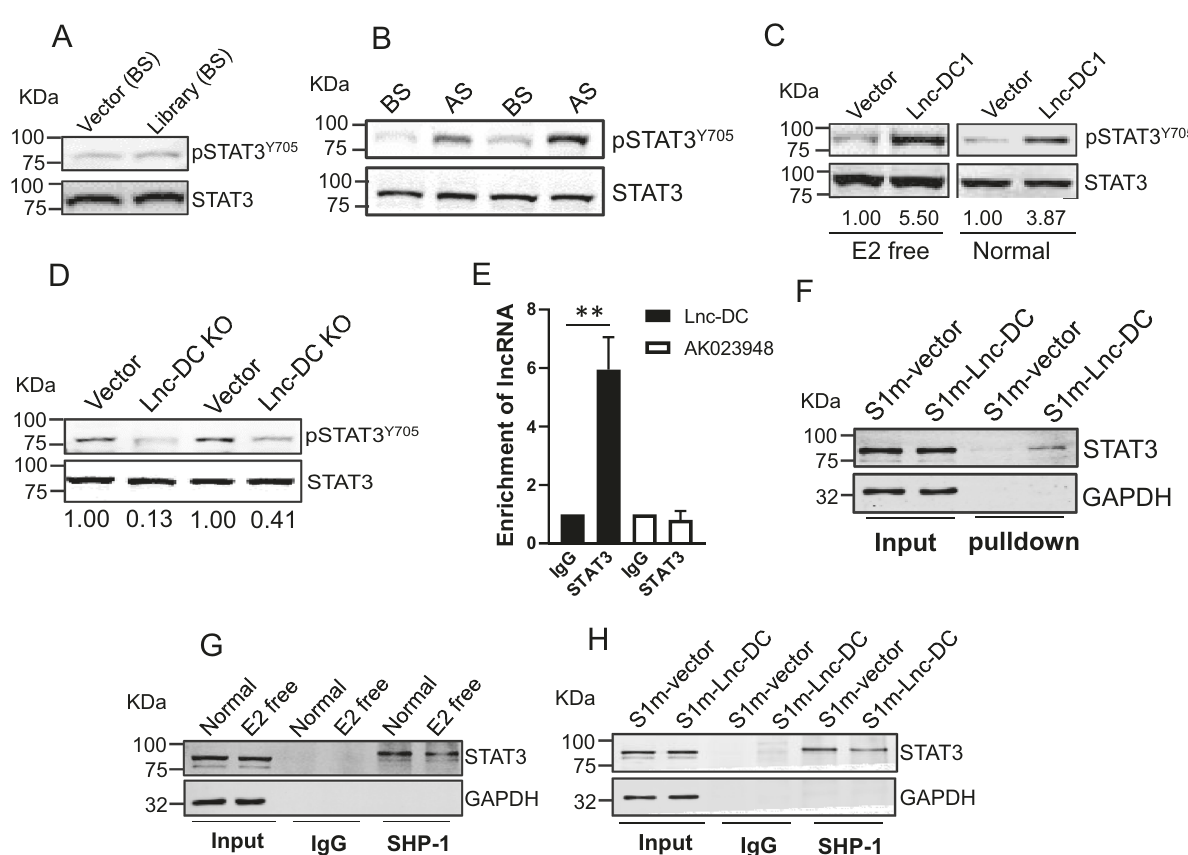
Fig. 4 Lnc-DC promotes STAT3 activity by its interaction with STAT3. A There is no difference between vector control and library cells in the level of pSTAT3 Y705 before selection. B AS cells express a higher level of pSTAT3 Y705 than BS cells. C Lnc-DC1 upregulates the level of pSTAT3 Y705 as compared to vector control in either E2 free or normal medium. D Lnc-DC KO decreases the pSTAT3 Y705 level. E Lnc-DC interacts with STAT3, as determined by RNA immunoprecipitation using STAT3 antibody. AK023948 serves as a negative control. Values are mean ± SD ( n = 3). ** p < 0.02. F Interaction of Lnc-DC with STAT3 as determined by in vivo precipitation assay. MCF-7 cells were infected with S1m- Lnc- DC or S1m vector control. Two days later, cellular extracts were prepared for streptavidin precipitation, followed by western blot. G Estrogen deprivation reduces the interaction between STAT3 and SHP-1, as determined by co-immunoprecipitation with SHP-1 antibody. MCF-7 cells were cultured in E2 free medium for 7 days before harvesting for co-immunoprecipitation. H Lnc-DC also reduces the interaction between STAT3 and SHP-1, as determined by co-immunoprecipitation with SHP-1 antibody. MCF-7 cells were fi rst infected with S1m-Lnc-DC, and 2 days later, the cells were harvested for co-immunoprecipitation with SHP-1